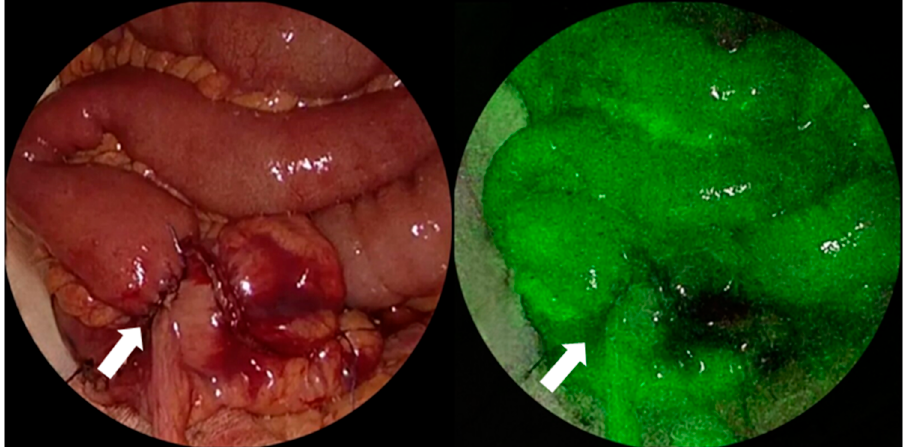
Figure 2. Intraoperative assessment of anastomotic perfusion using ICG ‐ FA in order to construct a well ‐ vascularized anastomosis (white arrows) and reduce the risk of postoperative AL. ICG ‐ FA, indocyanine green ‐ fluorescence angiography; AL, anastomotic leakage.